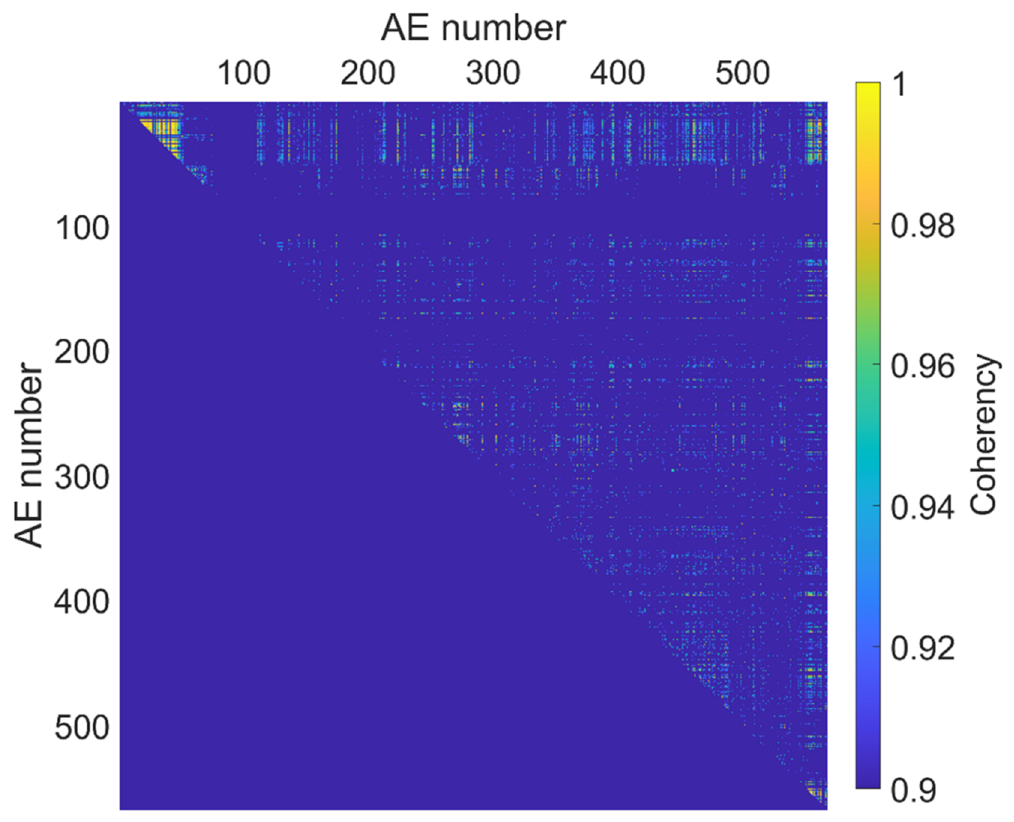
Figure 3. Coherency matrix for AEs of experiments G15. Coherency values are given by the color scale.